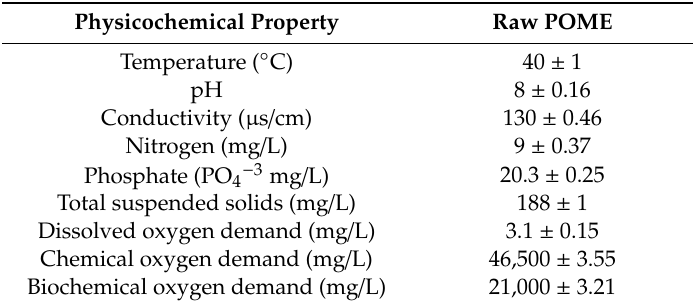
Table 1. Physicochemical properties of the raw palm oil mill e ffl uents (POME) used in this